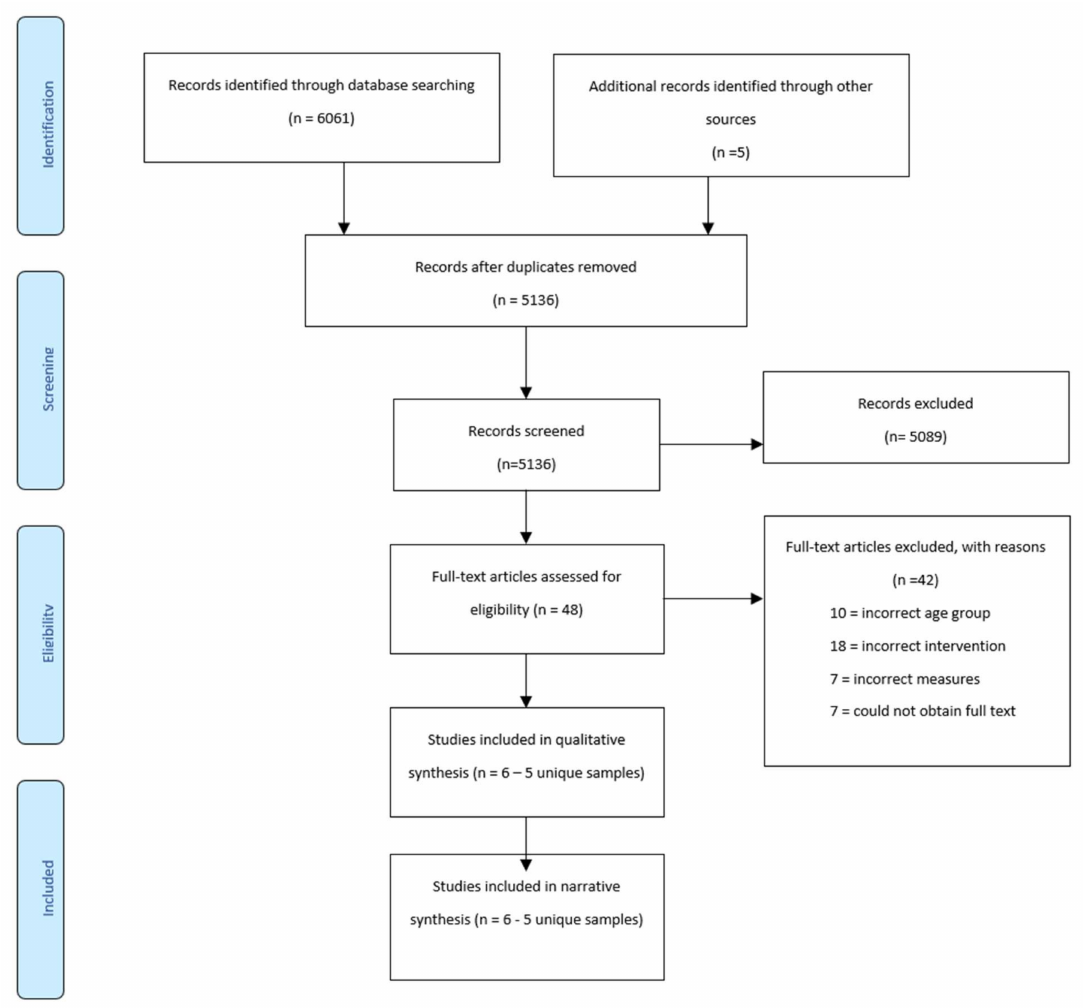
Figure 1. Prisma Diagram of search results